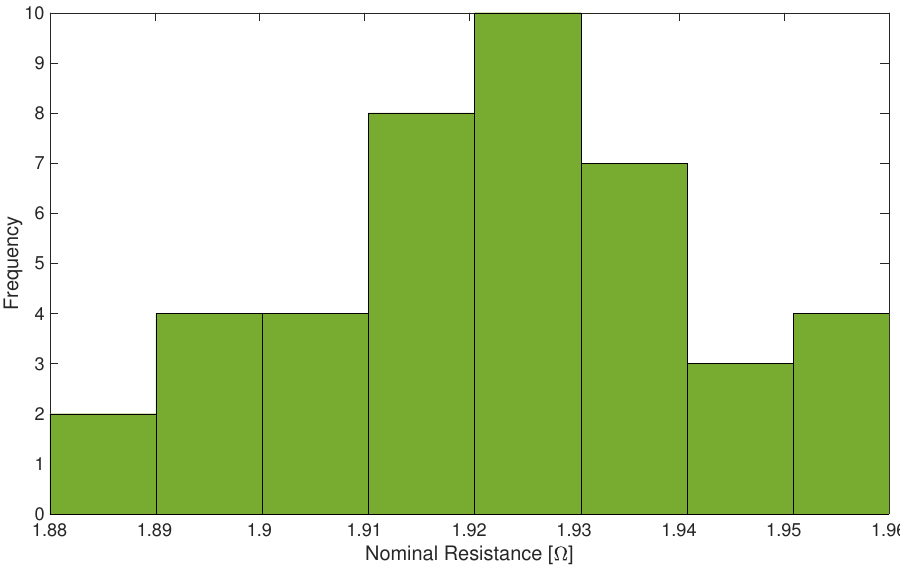
Figure 9. Histogram of nominal